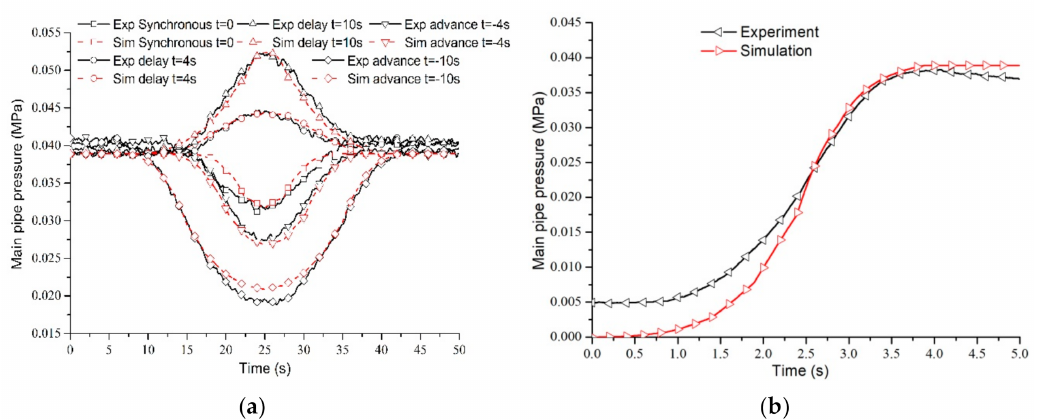
Figure 7. Unsteady flow performance verification: ( a ) Main pipe pressure when switching between two channels; ( b ) Main pipe pressure of the main valve opening from 0 to